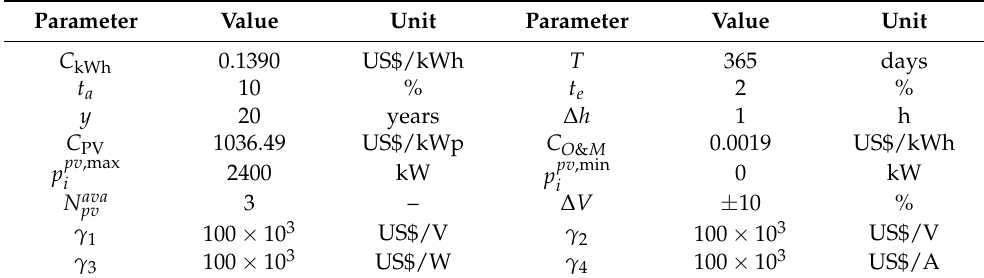
Table 3. Fitness and objective function